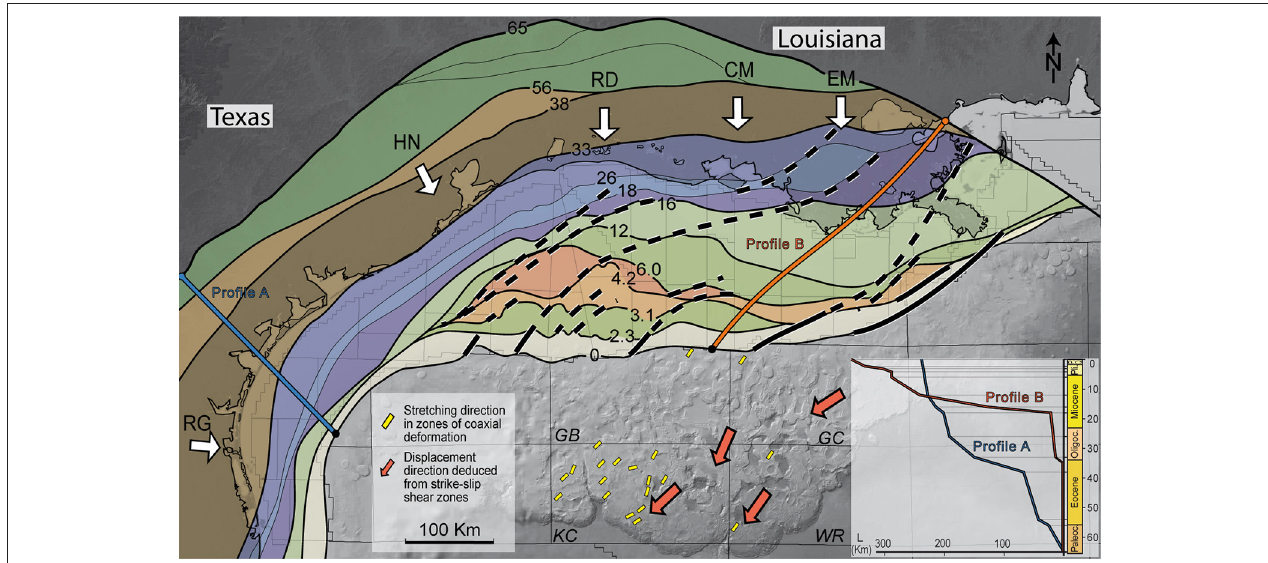
FIGURE 2 | Kinematics of continental shelf growth in the northern Gulf of Mexico [Modified after (Fort and Brun, 2012)]. Contours and ages (in My) of depositional episodes and main axes of sediment supply (White arrows) after Galloway et al. (2000). Solid black lines: Recent transfer zones (see Figure 1C ). Dashed lines: trace of previous transfer zones. The five main extrabasinal axes from which sediments filled the northern GoM margins are: RG, palaeo Rio Grande; HN, Houston; RD, Red; CM, Central Mississippi; EM, East Mississippi. Lower right insert: Curves of shelf break migration in the Northwestern margin (Profile A) and North margin (Profile B).